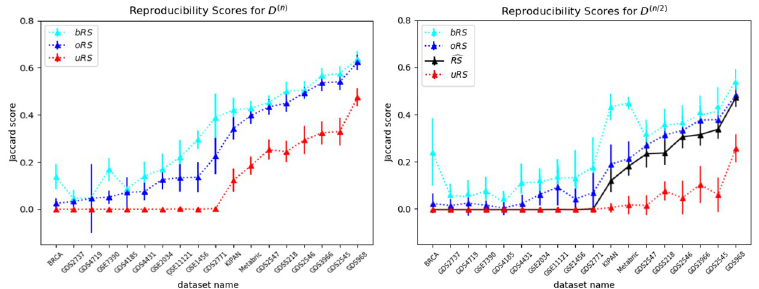
subjects (right), for k = 50 2